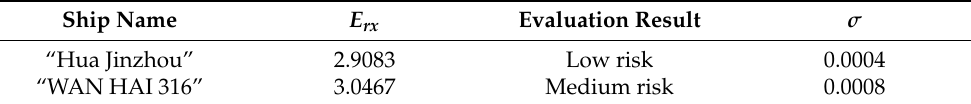
Figure 6. The risk level of each indicator of “WAN HAI 316”, “Z”, “Hua Jinzhou”, and “X”. (3) Calculate the security level and credibility factor according to Equations (21)–(24). The calculation results are shown in Table 10. Table 10. Final evaluation result for “Hua Jinzhou” and “WAN HAI